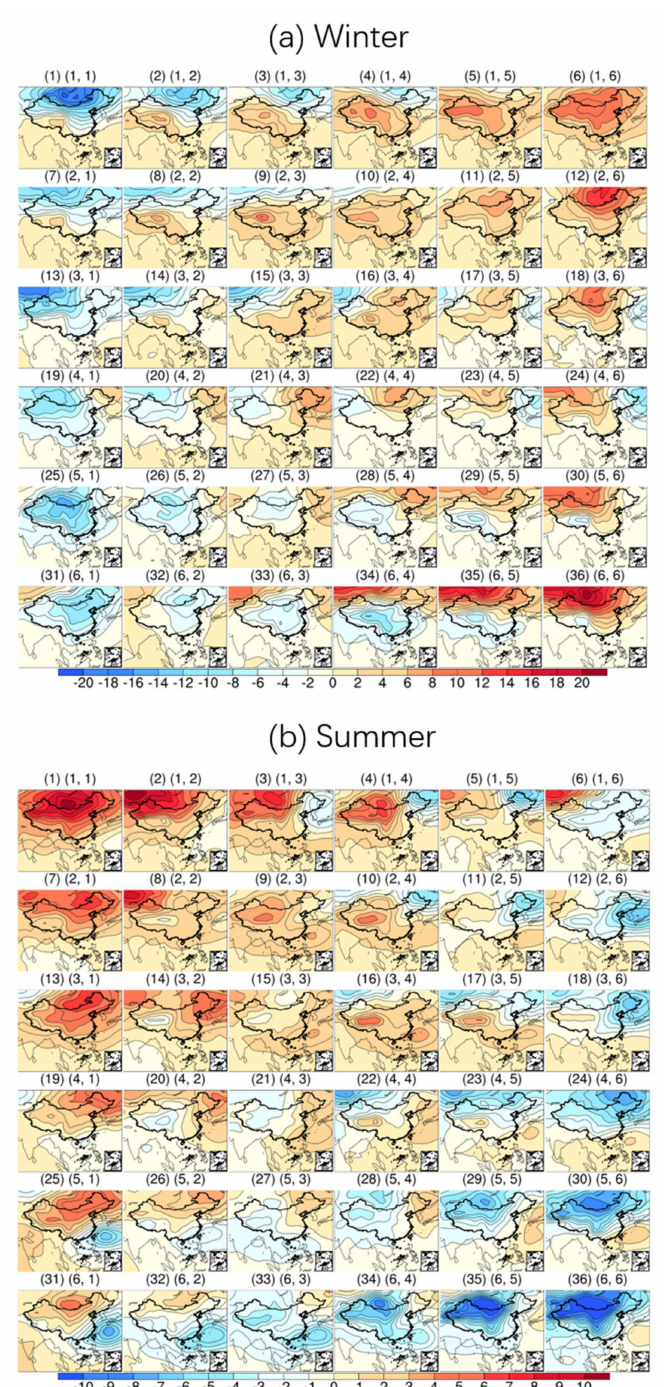
Figure 2. The 6 × 6 SOMs of temporal SLP anomalies (hPa) trained from the NCEP over the baseline period 1960–1999. Patterns (WPs) of temporal SLP anomalies: ( a ) in winter (DJF); and ( b ) in summer (JJA). There are 90 days per year in winter, for a total of 3600 days in 40 years, having an average of 2.78% (about 100 days) of each weather type, a maximum of 4.08% (about 147 days) in category 36, and a minimum of 1.53% (about 55 days) in category 11. The frequency of all WPs is plotted in Figure 4a. There are 92 days per year in summer, for a total of 3680 days in 40 years, having an average of 2.78% (about 102 days) per weather type, a maximum of 4.32% (about 159 days) for category 36, and a minimum of 1.88% (about 69 days) for category